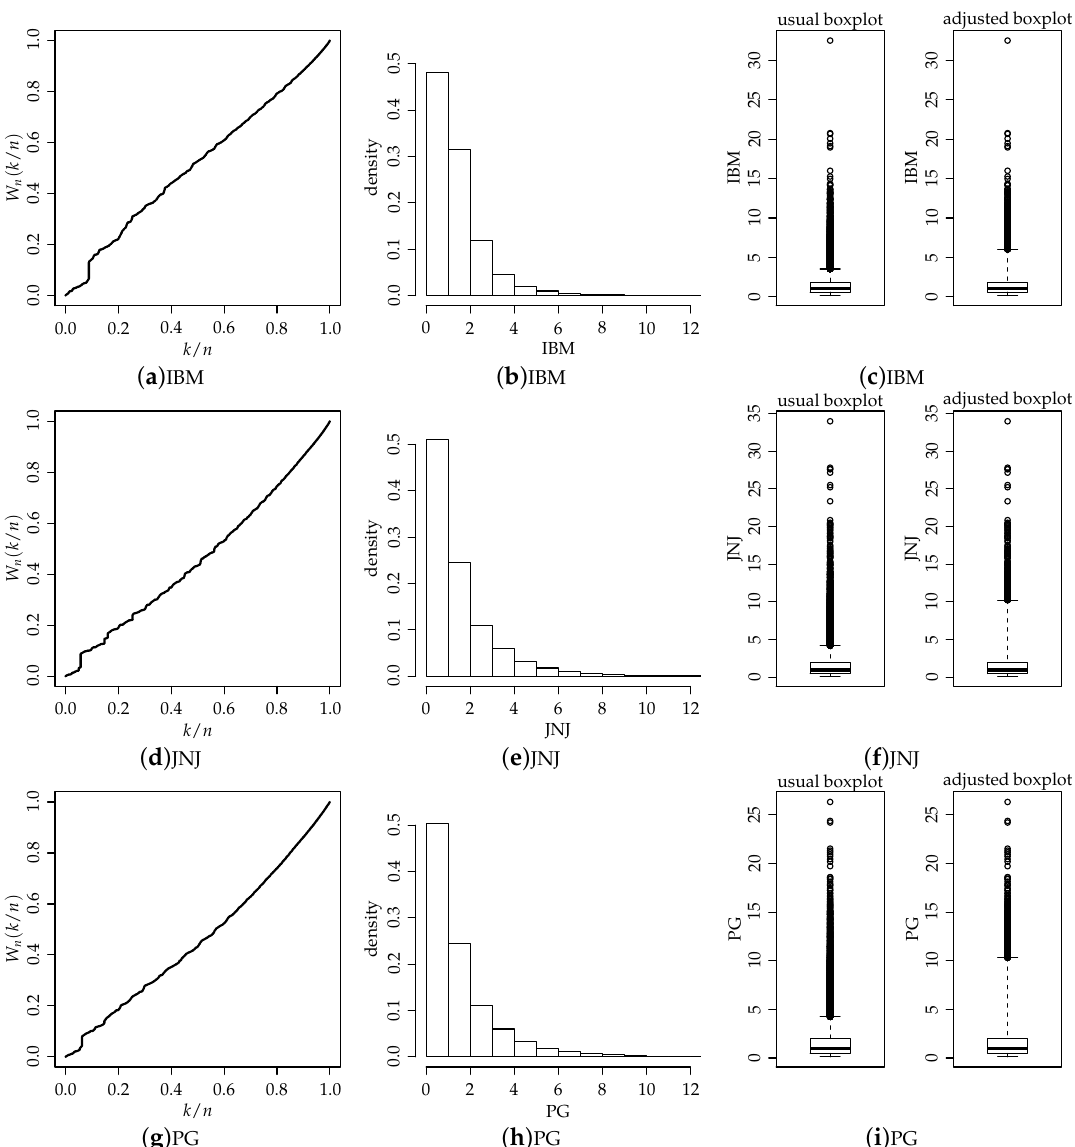
Figure 3. Total time on test (TTT) plot ( a ), histogram ( b ), and usual and adjusted boxplots ( c ) for the indicated data sets.